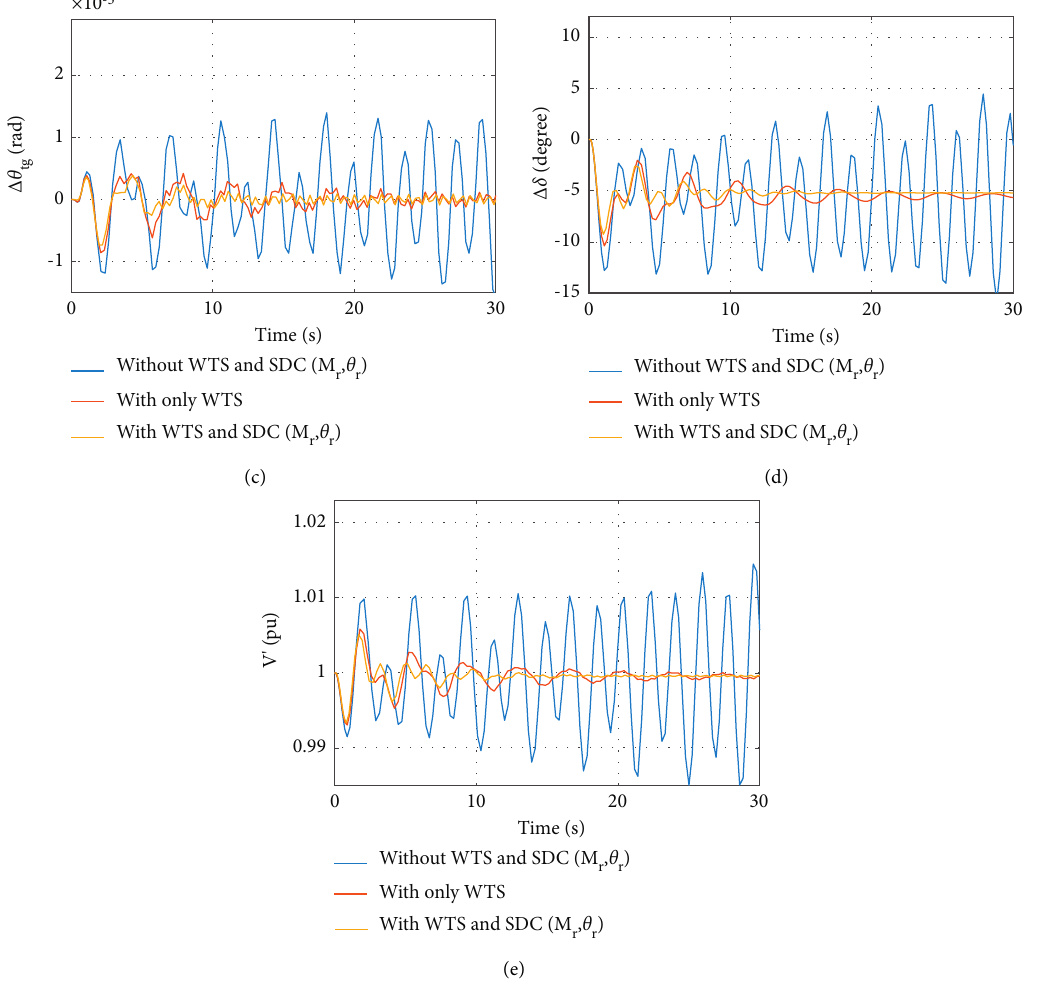
V w ≈ 14m/s). (c) The angular